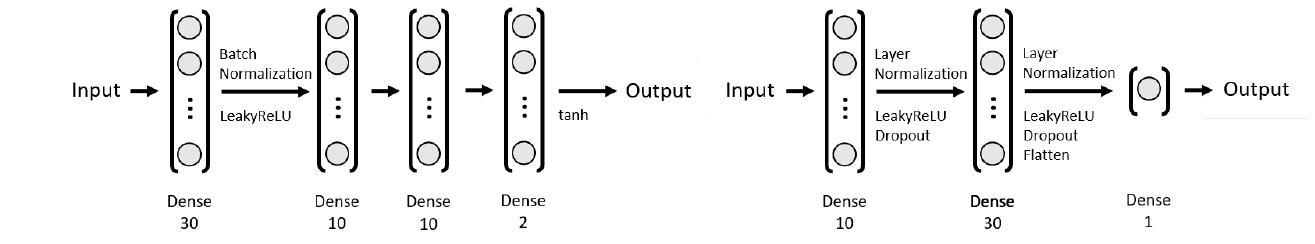
Figure 4. The structure of the generator ( left ) and critic ( right ) for the majority of the problems in this